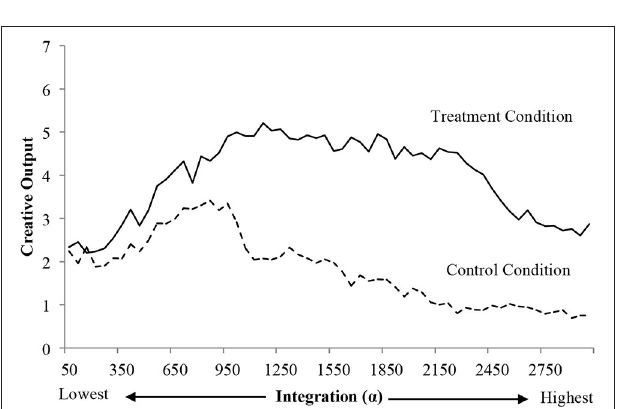
FIGURE 8 | Comparison of creative output between control ( ψ = 0.45) and treatment ( ψ = 0.25) levels of differentiation across the integration continuum.